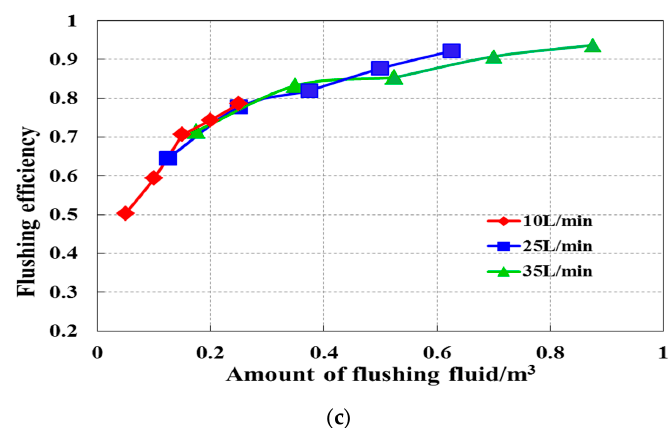
Figure 11. The relationship between the amount of flushing fluid and flushing efficiency under the condition of 30% flushing fluid concentration. ( a ) is ultra-low permeability core 0.1 mD, ( b ) is medium permeability core A 10 mD, ( c )is medium permeability core B 150 mD. It can be seen from Figure 11 that when the core permeability is 0.1 mD, 10 mD, and 150 mD, the flushing efficiency is 90% when the flushing fluid consumption is 0.2 m 3 (Figure 11a), 0.36 m 3 (Figure 11b), and 0.6 m 3 (Figure 11c), respectively. The flushing effect is better than that of 20% solution. According to the data in Table 4 above, the relationship between flushing time and flushing efficiency under different cores can be obtained, as shown in Figure 12.